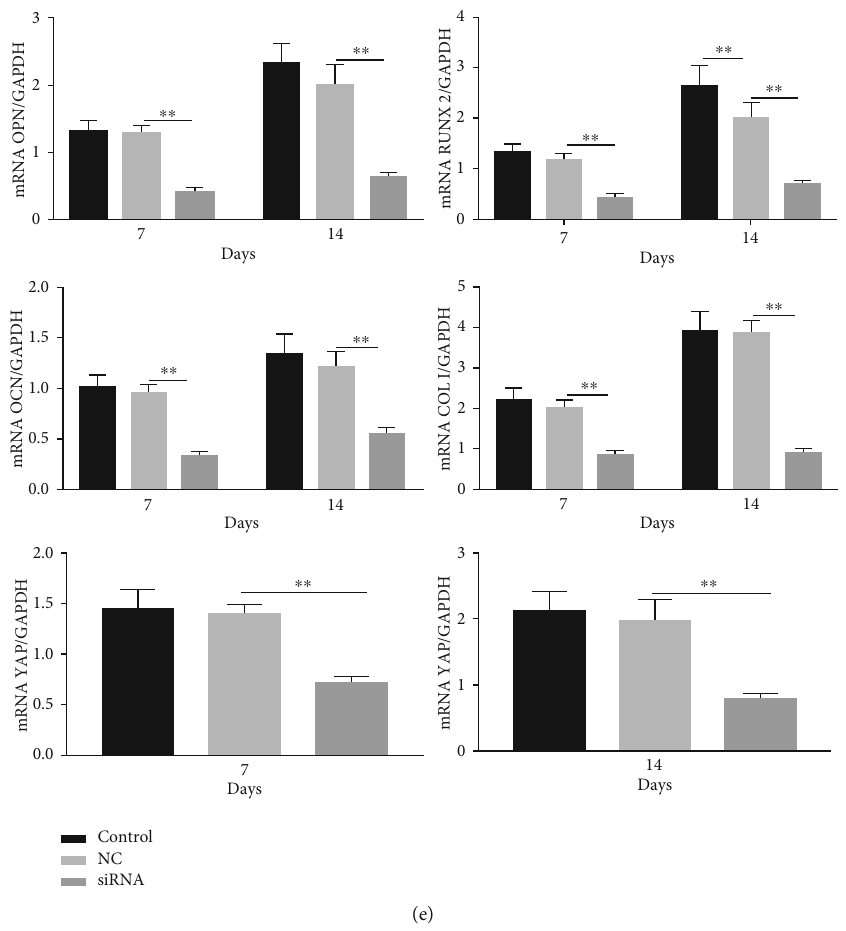
Figure 7: YAP silencing and its e ff ects on osteogenic di ff erentiation. EMSCs transfected with YAP siRNA and control siRNA were cultured in osteogenic di ff erentiation medium for 14 days. Representative images of (a) ARS and (b) ALP activity showing the mineralized bone matrix on day 14. (c, d) Quanti fi cation of the area of calcium mineral nodules and ALP activity. (e) Expression of osteogenic-related genes in transfected EMSCs assayed using real-time qPCR on days 7 and 14 after di ff erentiation. ∗ P < 0 : 05 and ∗∗ P < 0 : 01 . Bars = 25 μ m